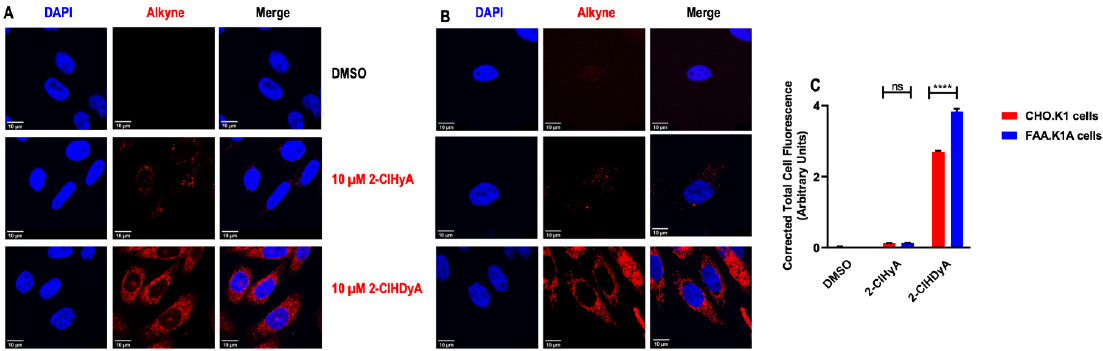
Figure 2. Confocal imaging of proteins modified by 2-ClHDyA and 2-ClHyA in CHO.K1 (A) and FAA.K1A (B) cells. CHO.K1 and FAA.K1A treated with 2-ClHDyA and 2-ClHyA as described in Figure 1 were subjected to confocal microscopy as described in Section 2. TAMRA in red indicates localization of proteins modified by 2-ClHDyA and 2-ClHyA and blue is DAPI nucleus staining; ( C ) Total corrected cell fluorescence was measured using ImageJ from CHO.K1 and FAA.K1A cells treated with DMSO, 10 µ M 2-ClHDyA or 10 µ M ClHyA following 1 h incubation. Mean + SEM **** p < 0.0001 and not significance (ns) for comparison within 2-ClHDyA and 2-ClHyA treatment between CHO.K1 and FAA.K1A cells, respectively.